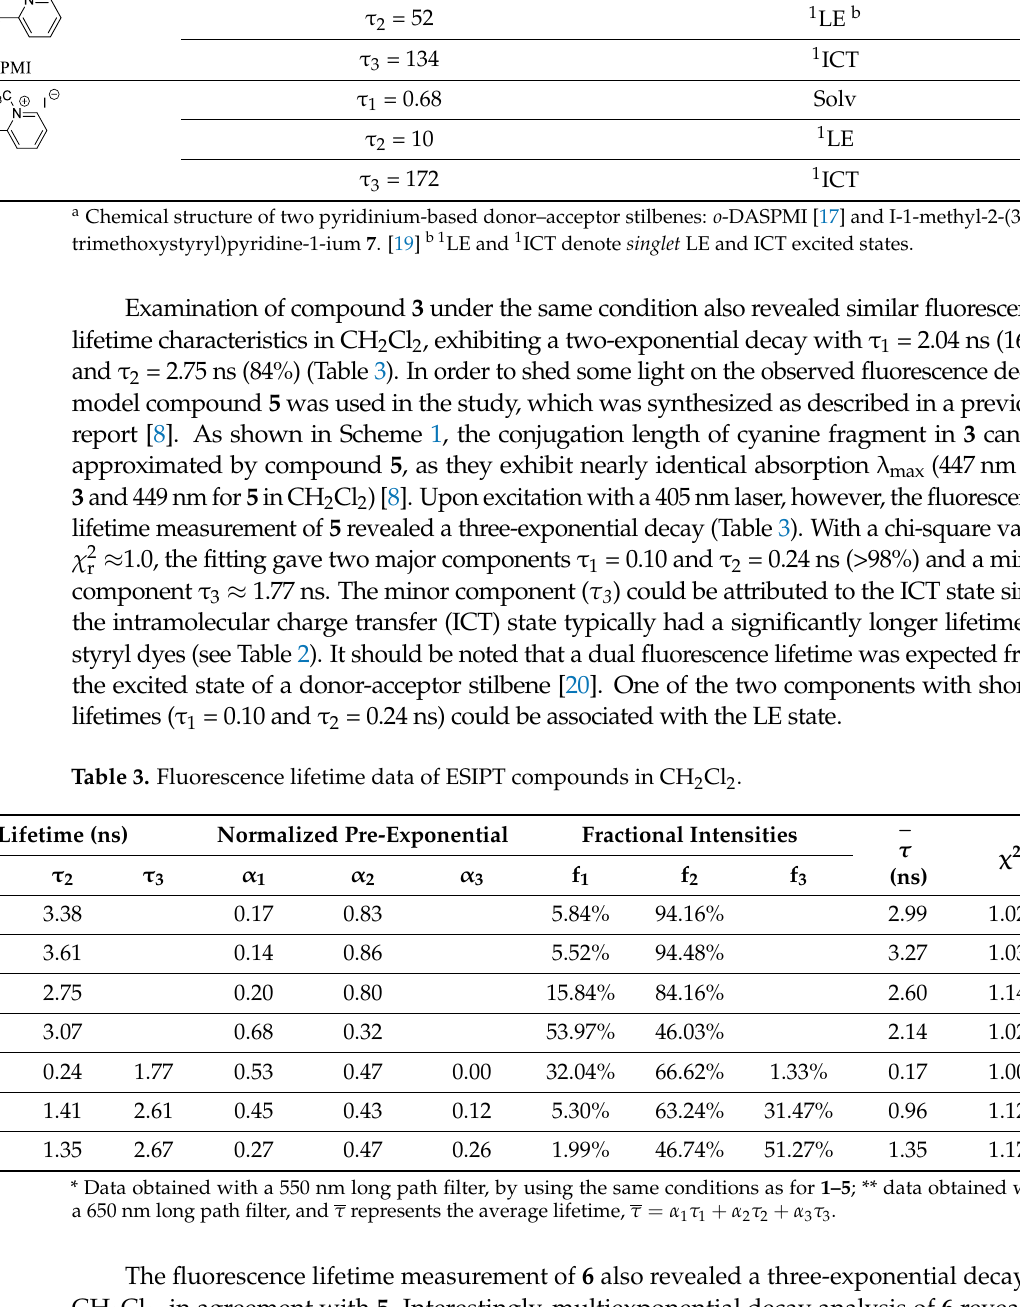
Table 2. Fluorescence lifetime of two pyridinium-containing styryl dyes in CH 2 Cl 2 (from reference [19], Copyright © 2022, American Chemical Society).